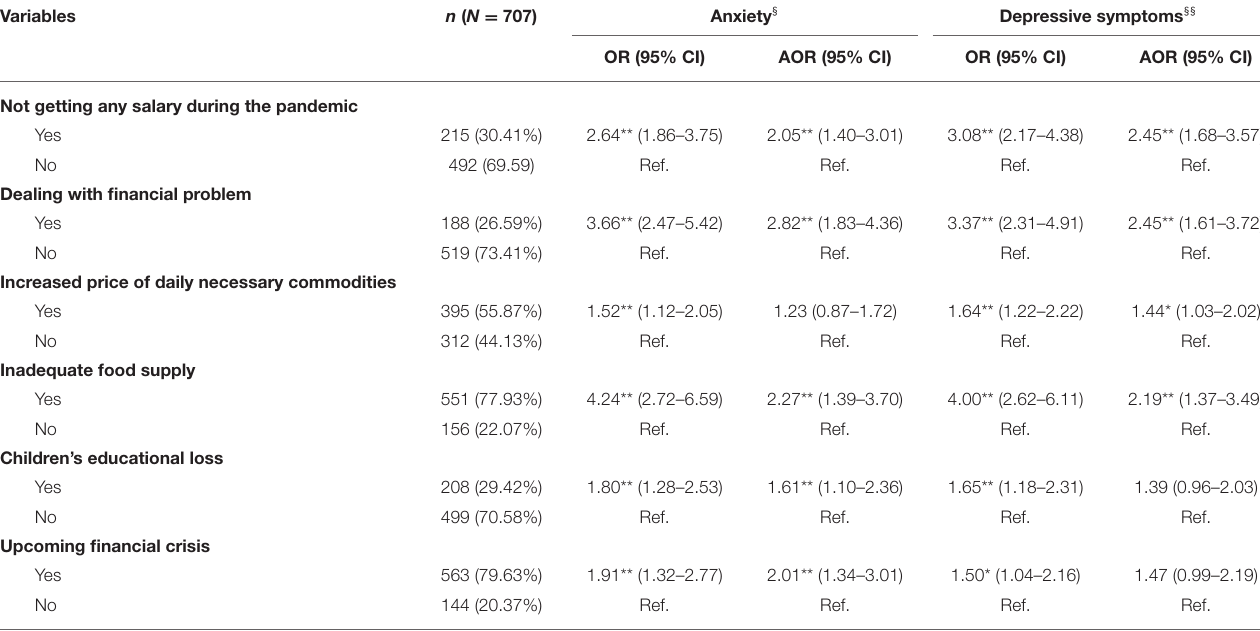
TABLE 3 | Association among social & financial stressors, anxiety and depressive symptoms among adult wage earners in Bangladesh. Variables n ( N = 707) Anxiety § Depressive symptoms